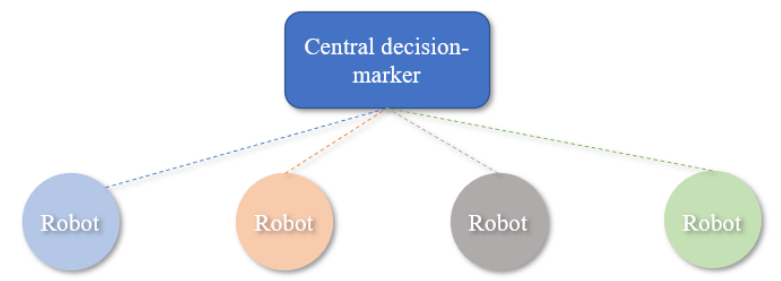
Figure 10. Structure of a centralized framework.